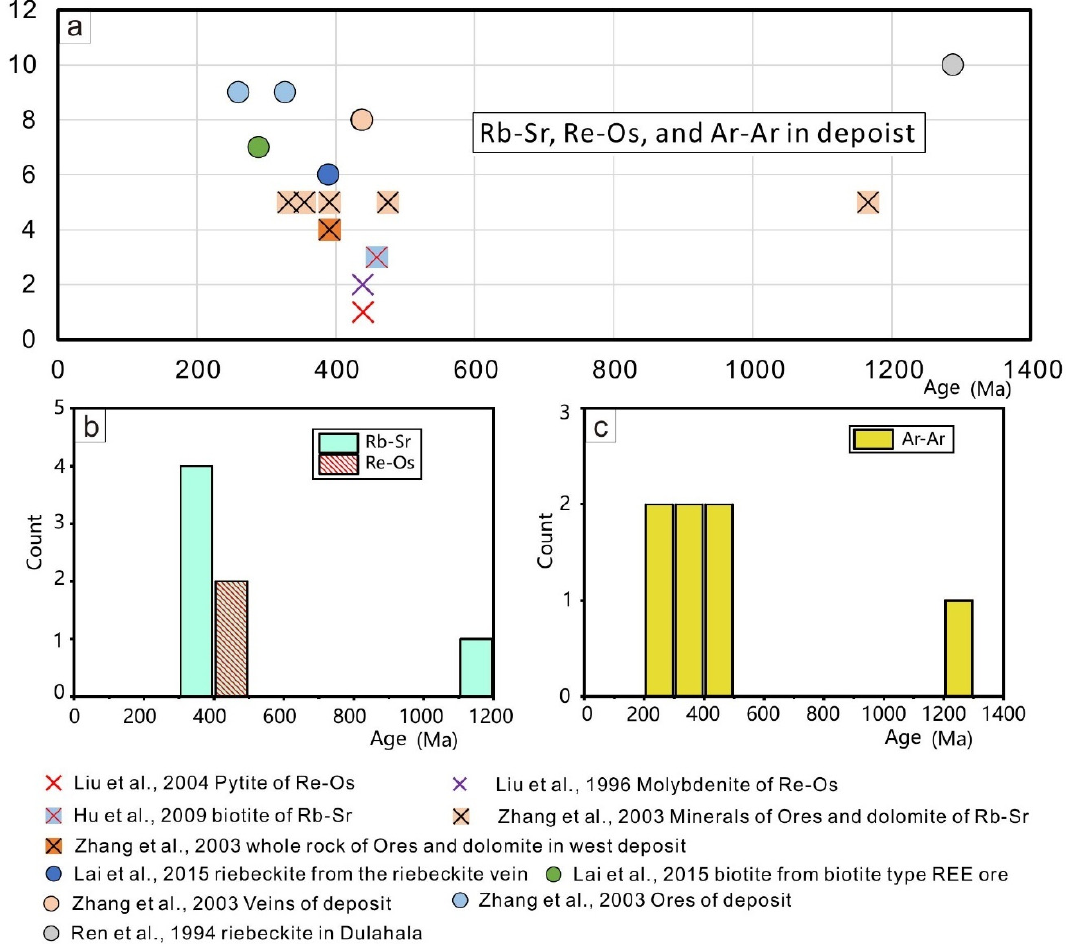
Figure 16. Age distribution characteristics of Rb–Sr, Re–Os, and Ar–Ar in the ore deposit. ( a ) Single age distribution characteristics corresponding to different studies. ( b , c ) Stack histograms of all ages